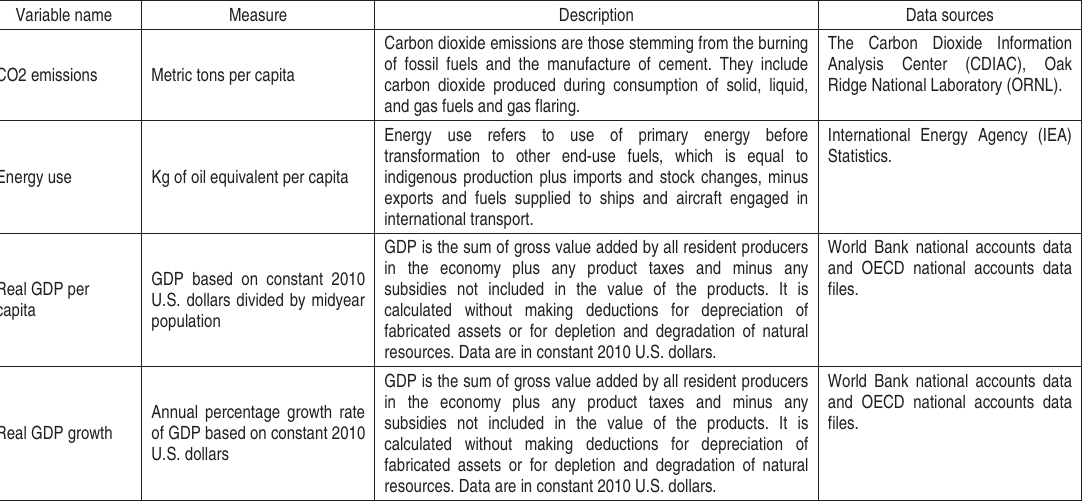
Table A.2. Data sources and